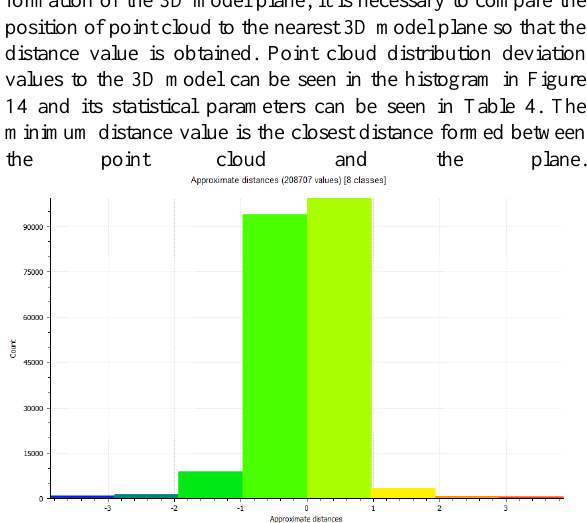
Figure 14. Deviation value histogram of point cloud (X axis in